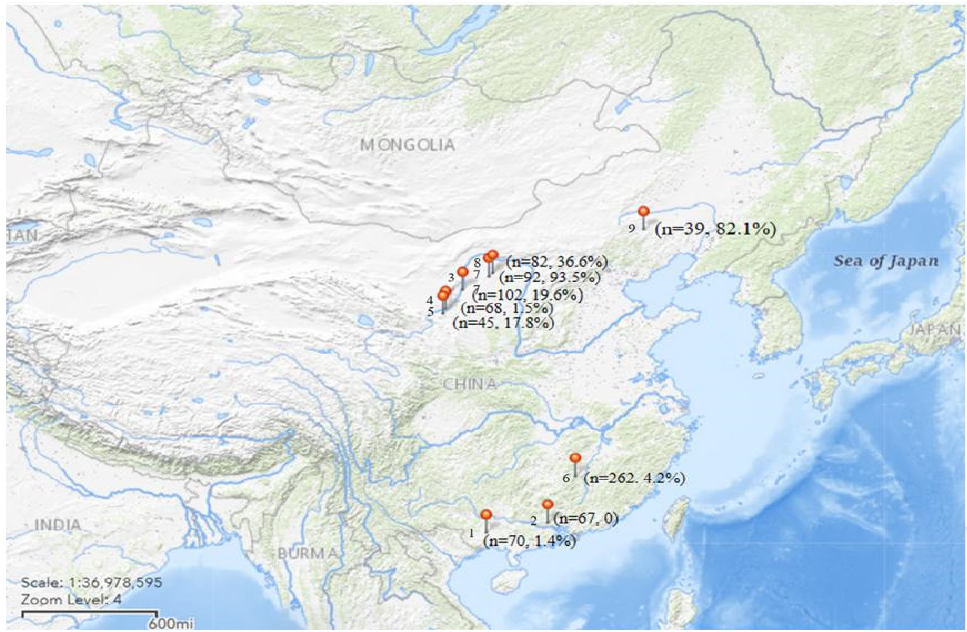
Figure 1. The isolation rate of Aeromonas in various regions. The stars indicate different sampling locations and the numbers on the left are sorted by sampling time. Sampling locations: 1. Nanning,